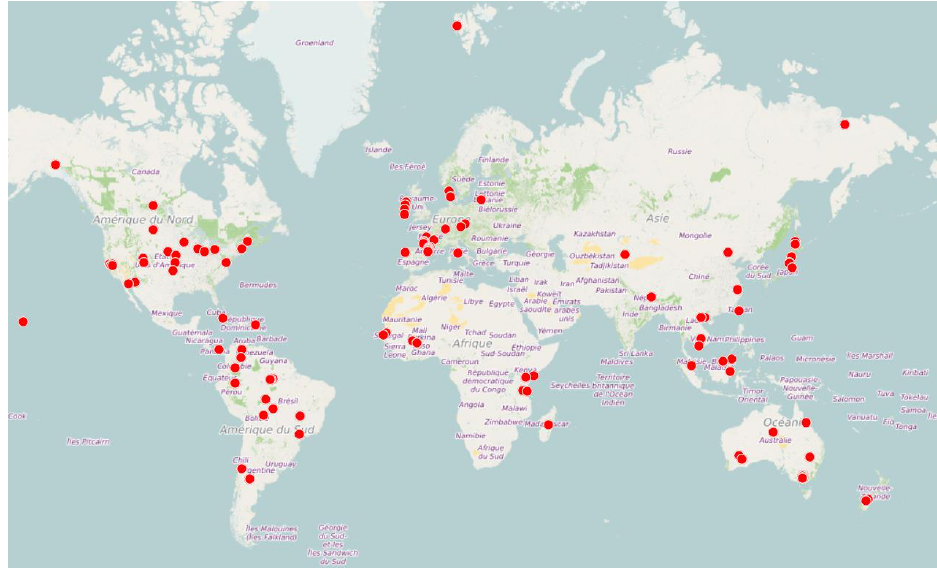
Figure 35. Map of location of scientific sites acquired during VM01.